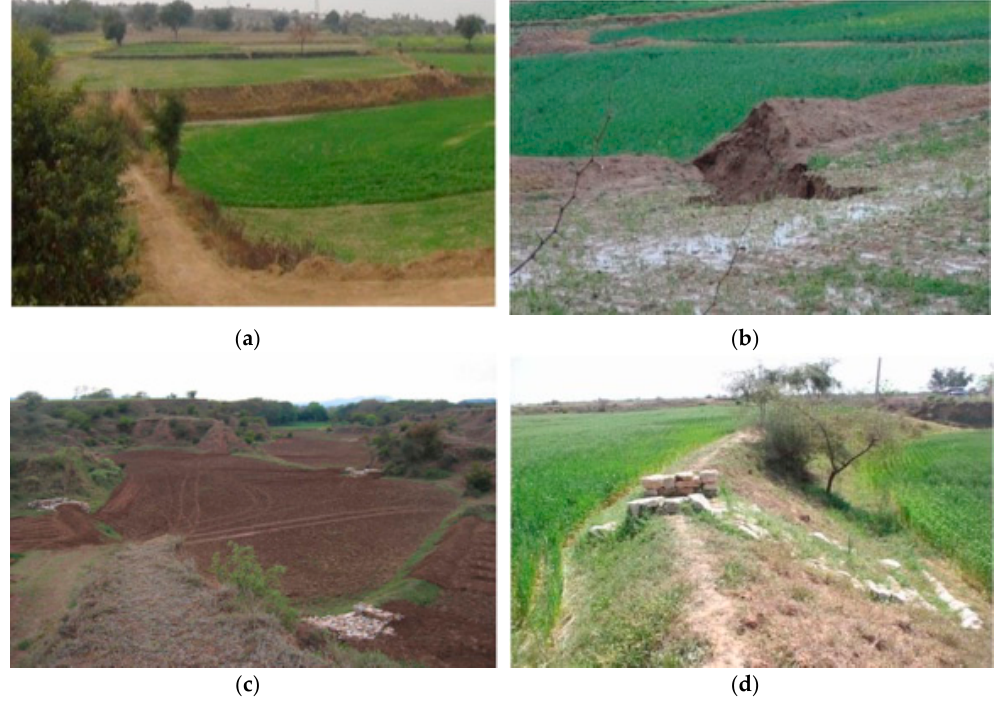
Figure 2. Soil and water conservation structures: ( a ) Terraced cultivated lands in Pothwar. ( b ) Breached terrace bund/embankment. ( c ) Loose stone structures system. ( d ) A loose stone structure in the field.